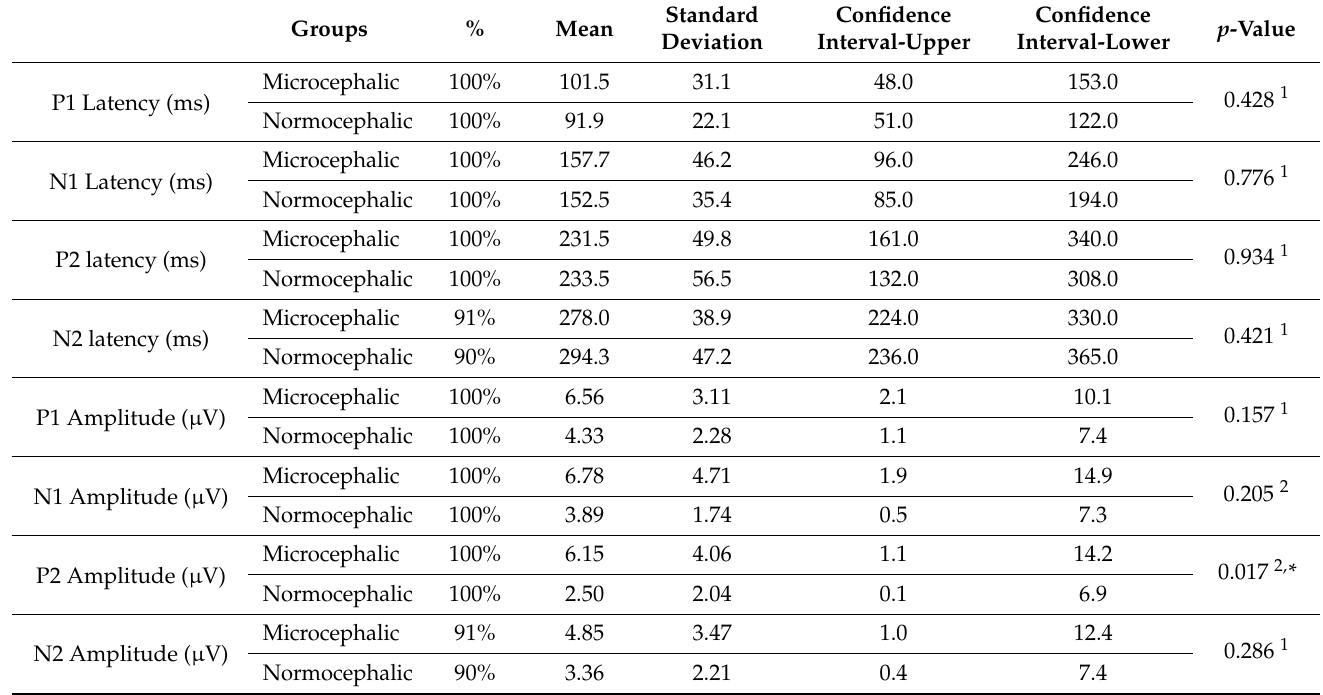
Table 2. Results of comparing the measures of latency and amplitude of the CAEP in children prenatally exposed to ZIKV with microcephaly ( n = 11) and without microcephaly ( n = 10). Groups % Mean